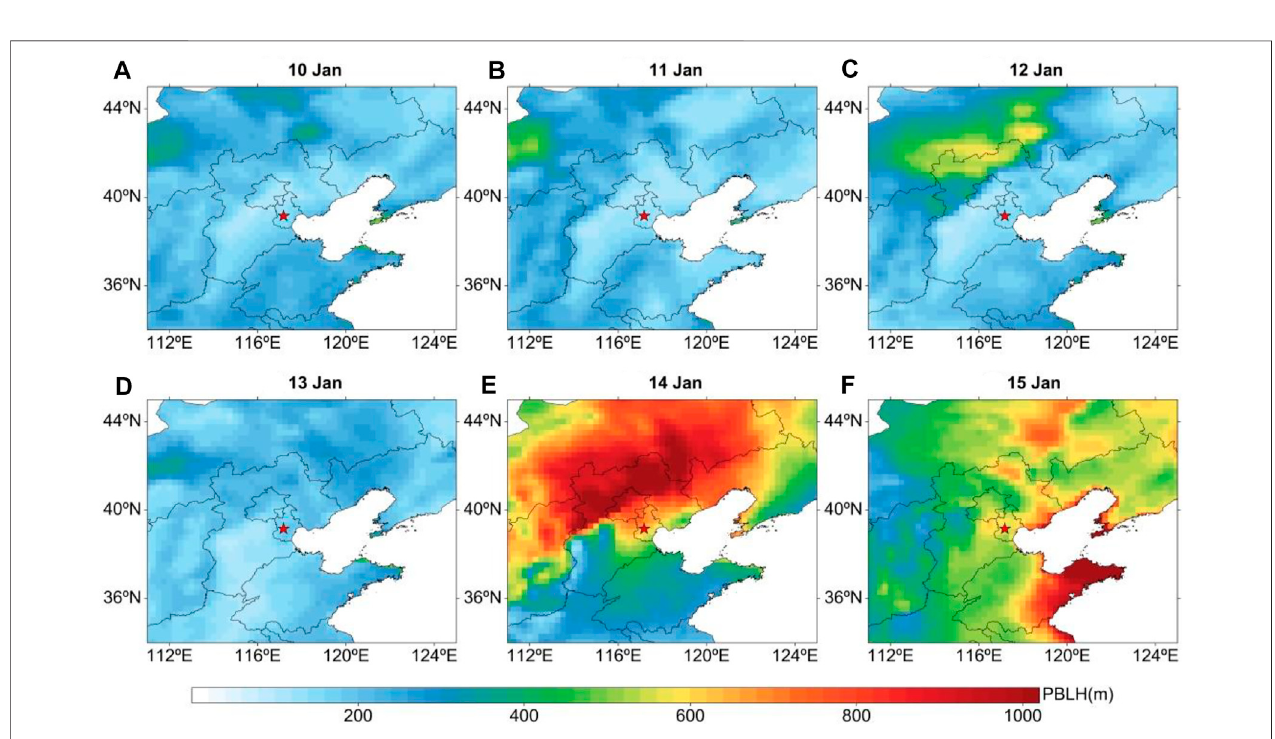
Frontiers in Environmental Science |